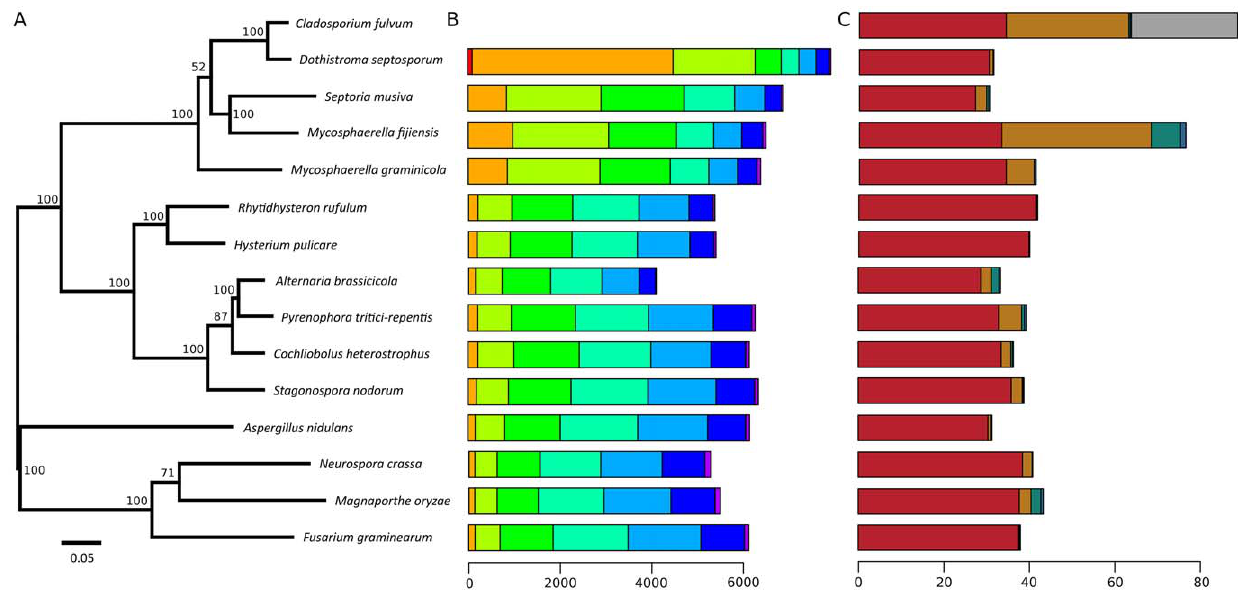
Figure 2. Species phylogeny, amino acid similarity, and repeat content. A) Maximum likelihood phylogenetic tree based on 51 conserved protein families showing evolutionary relationships of Cladosporium fulvum and Dothistroma septosporum . Branch lengths are indicated by the bar (substitutions/site); bootstrap values are shown as percentage. B) Genome-wide amino acid similarity of homologous proteins between C. fulvum and other sequenced fungal species. A pair of proteins is only reported as homologous when the predicted similarity (blastp) spans at least 70% of their lengths and their length difference is at most 20%. Axis indicates number of homologous proteins. Bar shading indicates similarity: red, 91–100%; orange, 81–90%; light green, 71–80%; medium green, 61–70%; turquoise, 51–60%; light blue, 41–50%; dark blue, 31–40%; and purple, 0–30%. Homologous proteins with high amino acid similarity are likely orthologs, whereas for those with lower similarity this relation cannot be inferred. C) Repeat content of C. fulvum , D. septosporum and other sequenced fungal species. Bar shading indicates repeat class: red, unique non-repeat regions; brown, repeat elements; green, continuous tracts of N characters; blue, duplicated regions; and grey, poorly assembled regions ( C. fulvum only). Axis indicates number of nucleotides